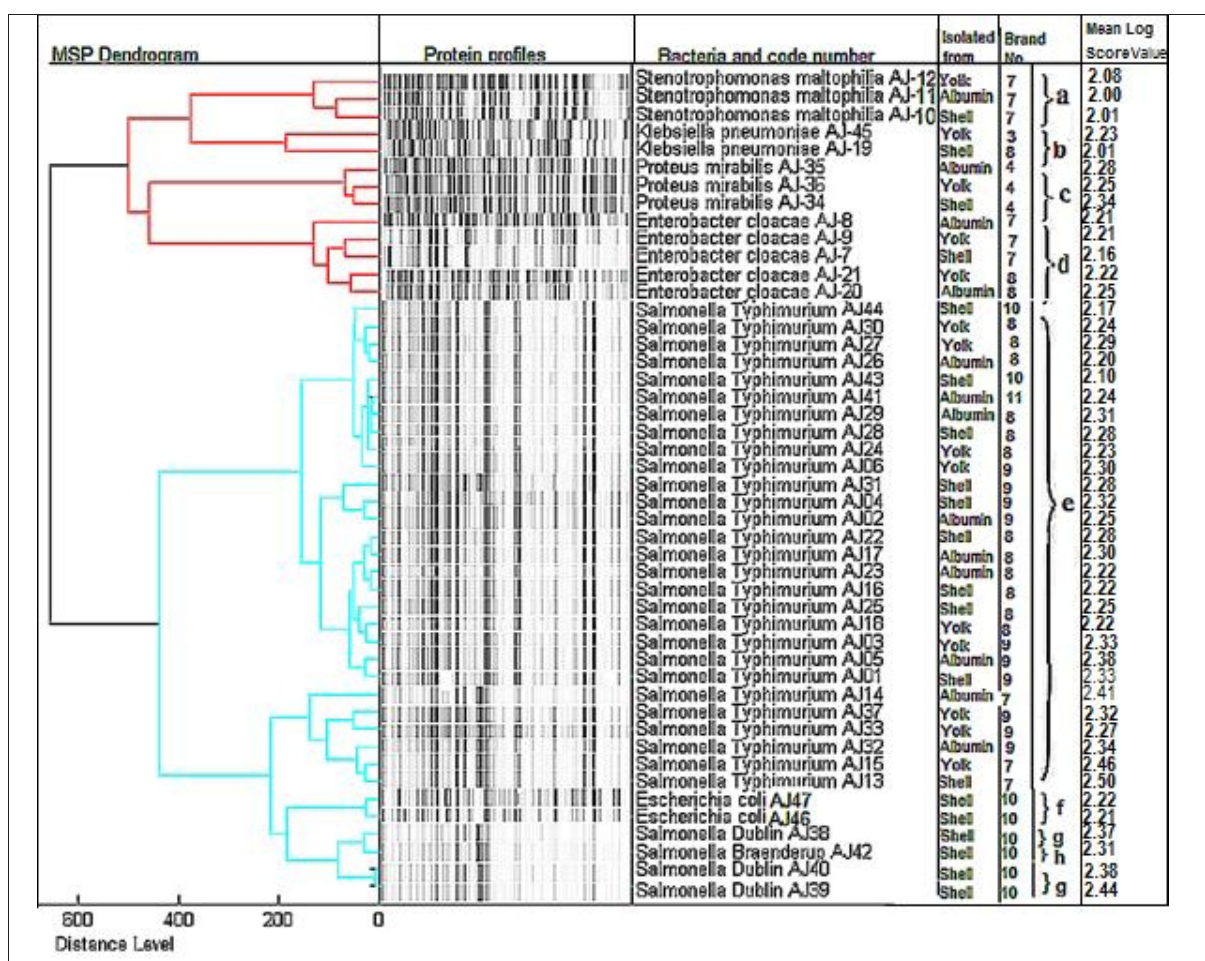
Figure 3: Dendrogram of mass spectral protein profiles in normalised gel of confirmed bacterial species showing log score values, isolates’ relationships with different egg brands, percentage relationship grouping (from a–h) and the portion of the eggs from where they were